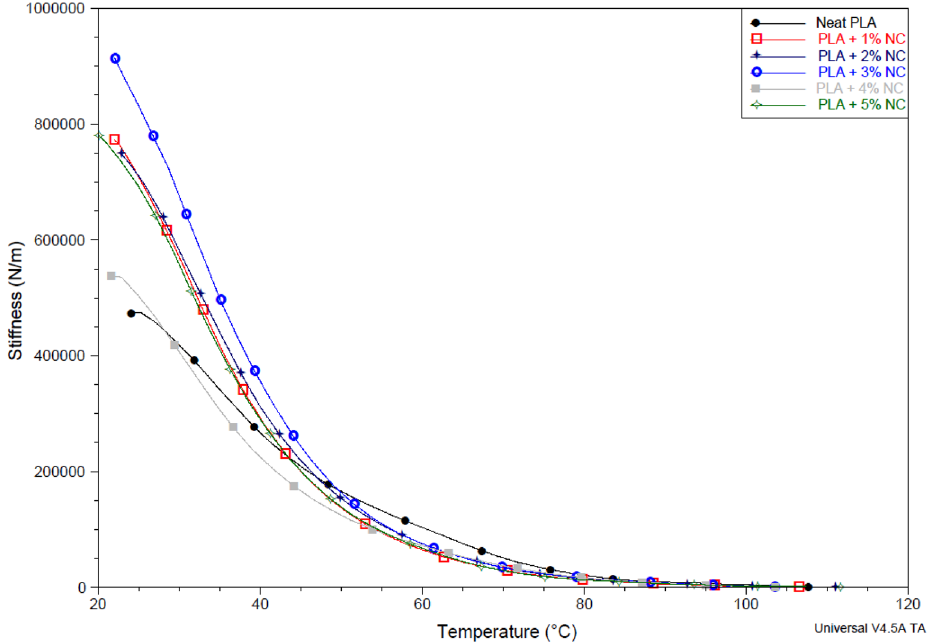
Figure 7. Stiffness of unfilled and nano-CaCO 3 reinforced polylactic acid bioplastic